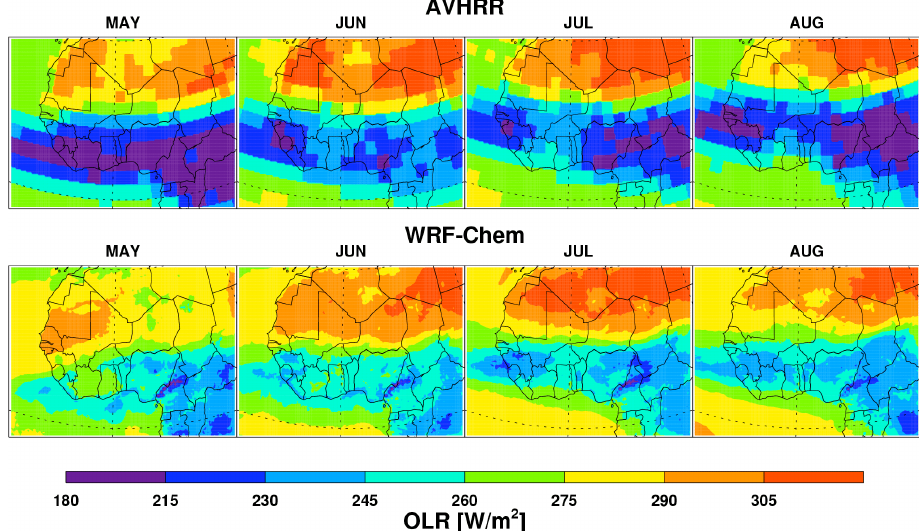
Figure 4 Monthly spatial distribution of outgoing longwave radiative fluxes (OLR) over 6 Fig. 4. Monthly spatial distribution of outgoing longwave radiative fluxes (OLR) over West Africa from the AVHRR retrievals and WRF- Chem simulations.